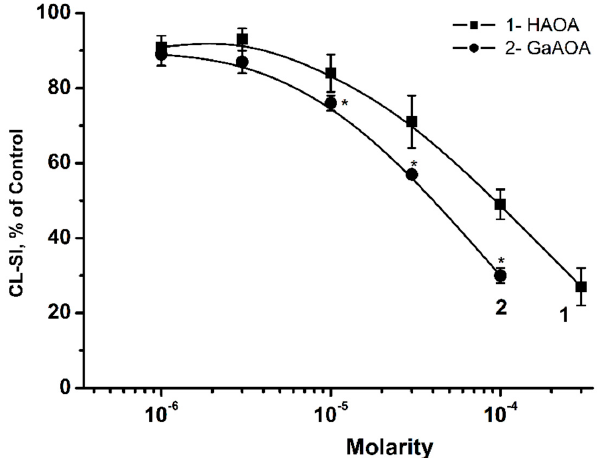
Figure 2. Effect of HAOA (curve 1) and GaAOA (curve 2) on the chemiluminometric scavenging index (CL-SI) in the superoxide-generating xanthine/xanthine oxidase (X/XO) model system. Data = mean ± SD ( n = 5). *, statistically significant difference from HAOA ( p < 0.05). Above a concentration of 3.0 × 10 − 6 M, the CL-SI of GaAOA (Figure 2, curve 2) corresponded to